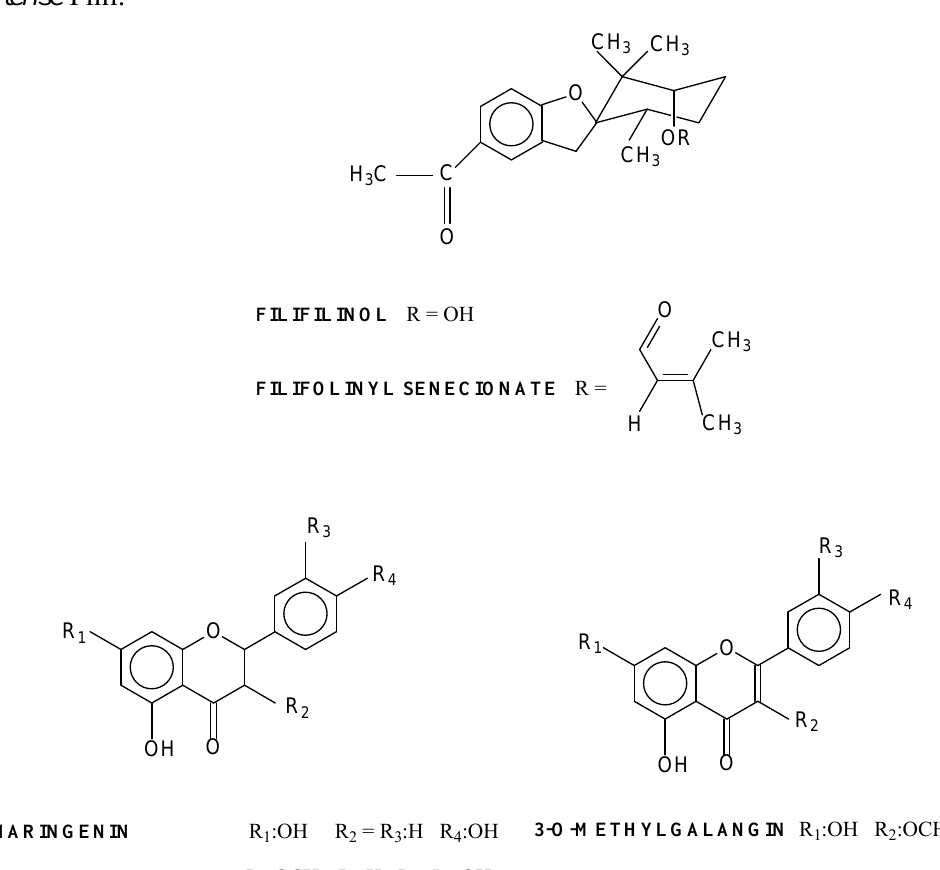
Figure 1. Structure of the compounds isolated from exudates resinous of Heliotropium taltalense Phil.